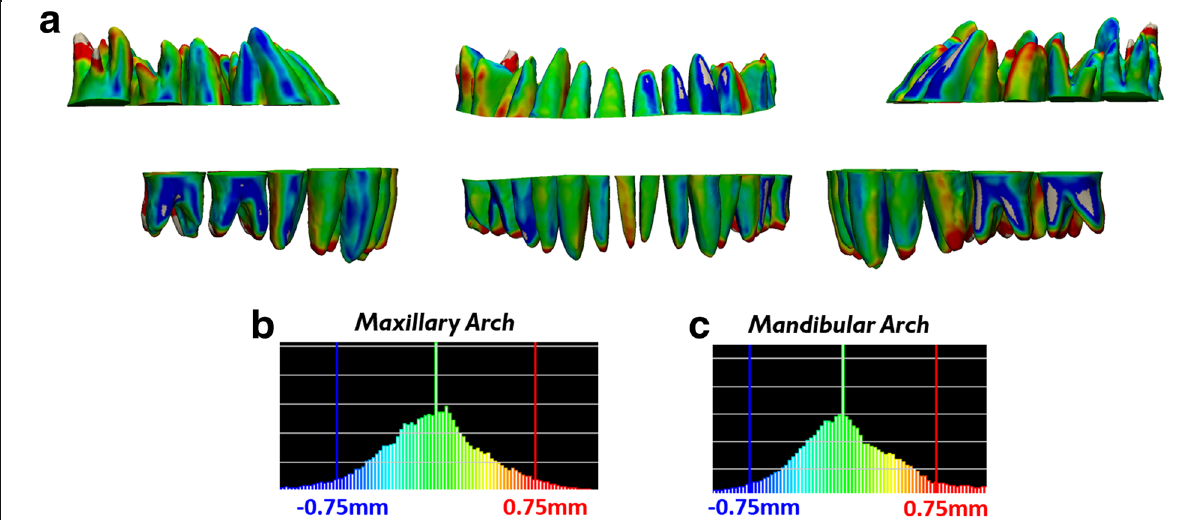
Fig. 8 Measurement of displacements between the roots after indirect superimposition of the ERP setup and reset appointment CBCT scan. a Color displacement maps comparing the root positions of the ERP setup and reset appointment CBCT scan. Green areas indicate 0.0 mm displacement; blue and red areas indicate equal to or greater than 0.75 mm. b , c Histograms showing the distribution of displacements between roots of the ERP setup and reset appointment CBCT scan in the maxillary arch and mandibular